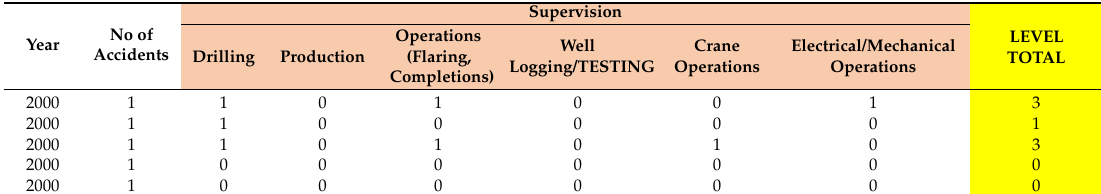
Table 2. Illustration of the sequence of TRACEr categories/taxa identified from the accident reports.